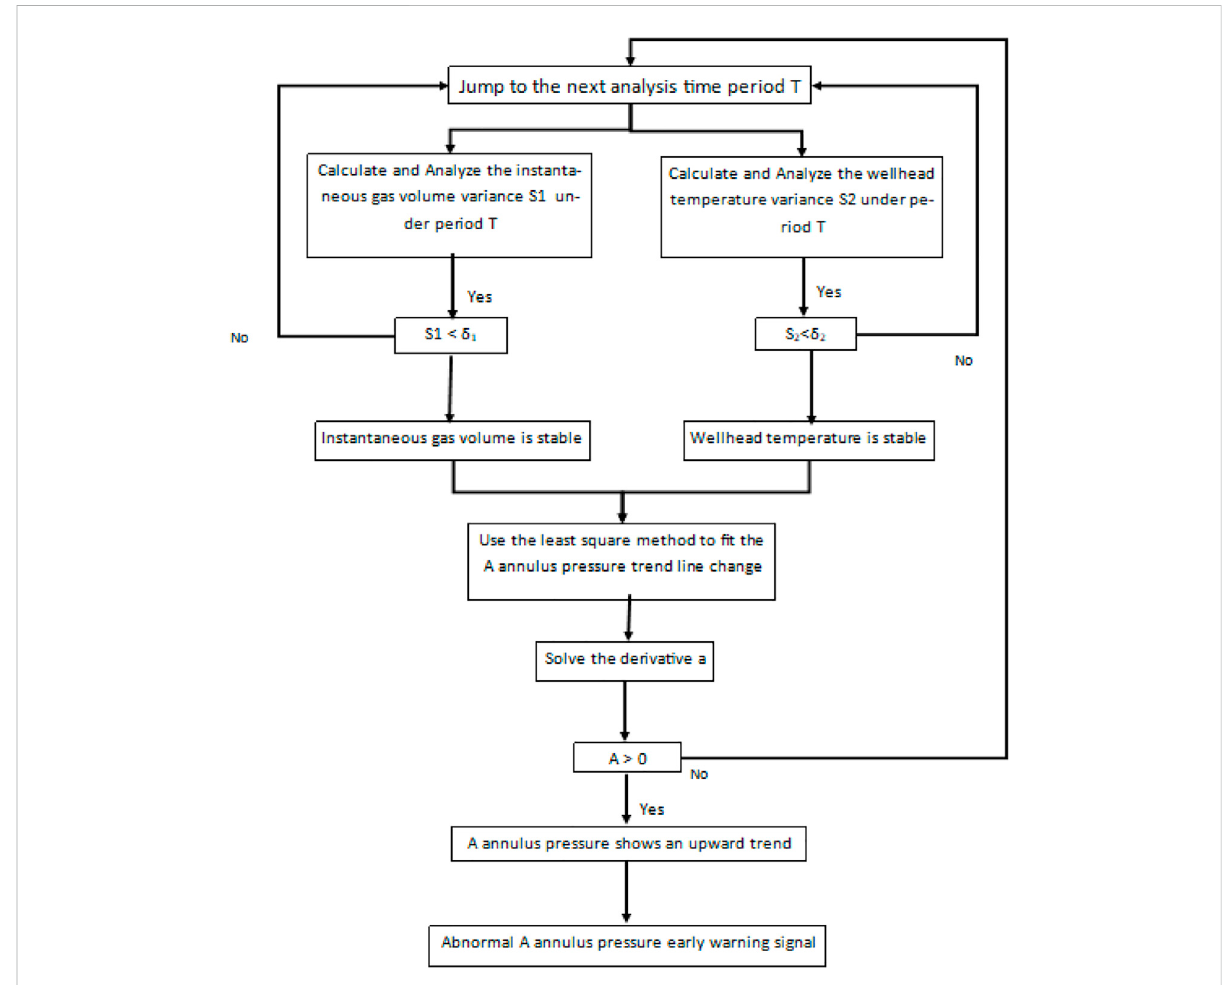
FIGURE 1 The early warning rules of abnormal annular